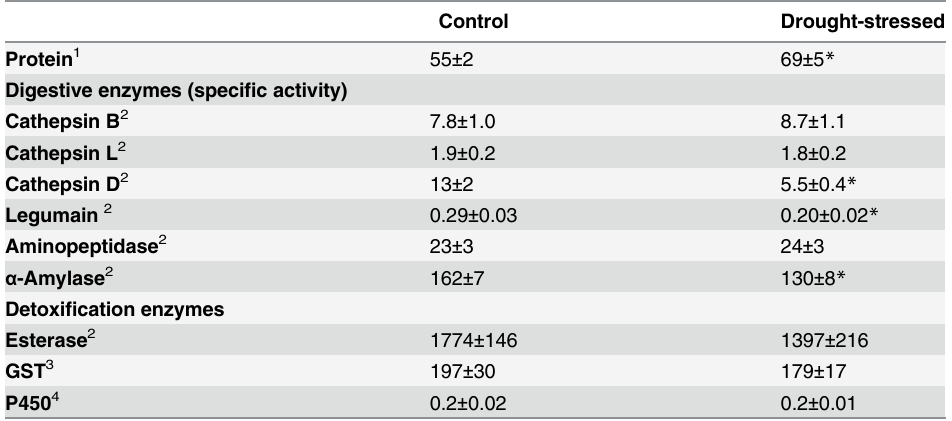
Table 3. Enzymatic activities in T . evansi feeding on moderate drought-stressed or control tomato plants for 10